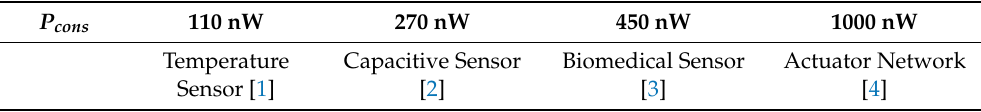
Table 1. State of the art wireless sensor power